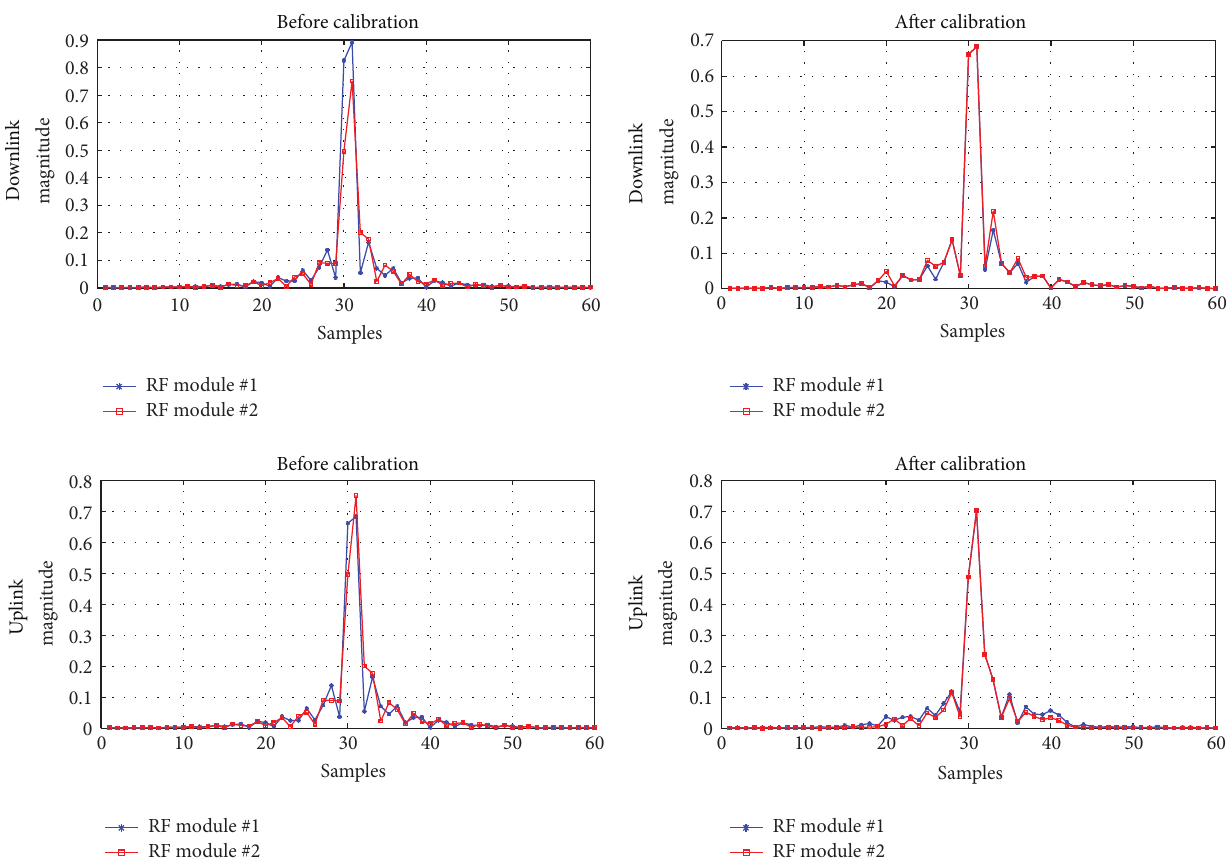
Figure 10: Impulse responses of the 2 RF modules before and after the proposed calibration.